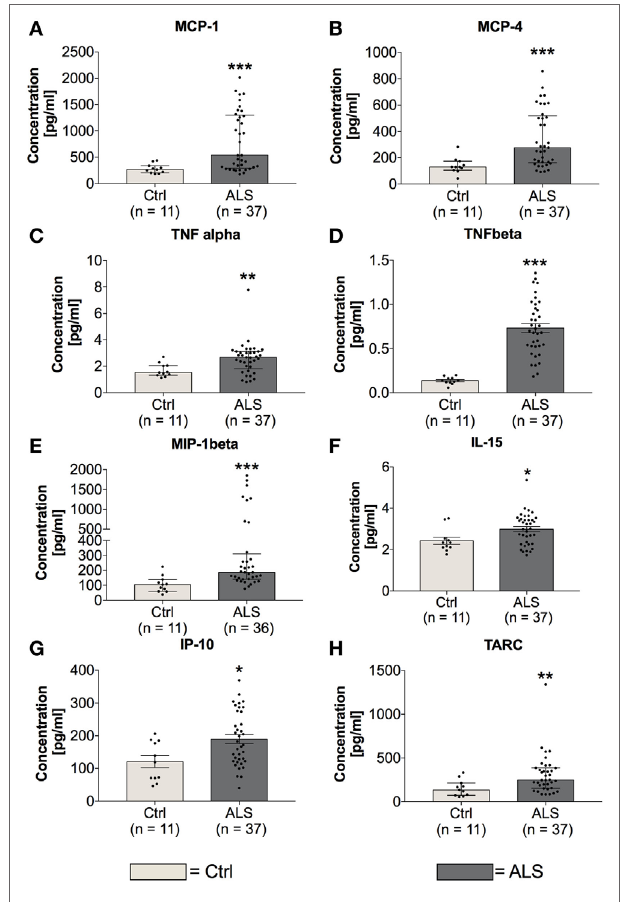
FigUre 2 | Serum concentrations of proinflammatory cytokines and chemokines. Amyotrophic lateral sclerosis (ALS) patients exhibited an upregulated peripheral proinflammatory immune response (a–h) . Circulating levels of the proinflammatory chemokines MCP­1 (a) and MCP­4 (b) as well as proinflammatory cytokines TNF α (c) , TNF β (D) , MIP­1 β (e) , IL­15 (F) , IP­10 (g) , and TARC (h) were significantly enhanced in ALS patients compared to healthy controls (Ctrl). * p < 0.05 vs. Ctrl, ** p < 0.01 vs. Ctrl, *** p < 0.001 vs. Ctrl. Numbers of patients are given in brackets; All parameters were tested for Gaussian distribution using D’Augostino­Pearson omnibus normality test. Two­tailed Mann–Whitney test for TNF α , MCP­1, MCP­4, MIP­1 β , IL­15, and TARC, data represent median with interquartile range; two­tailed unpaired Student’s t ­test for TNF β and IP­10, data represent mean ± SEM.